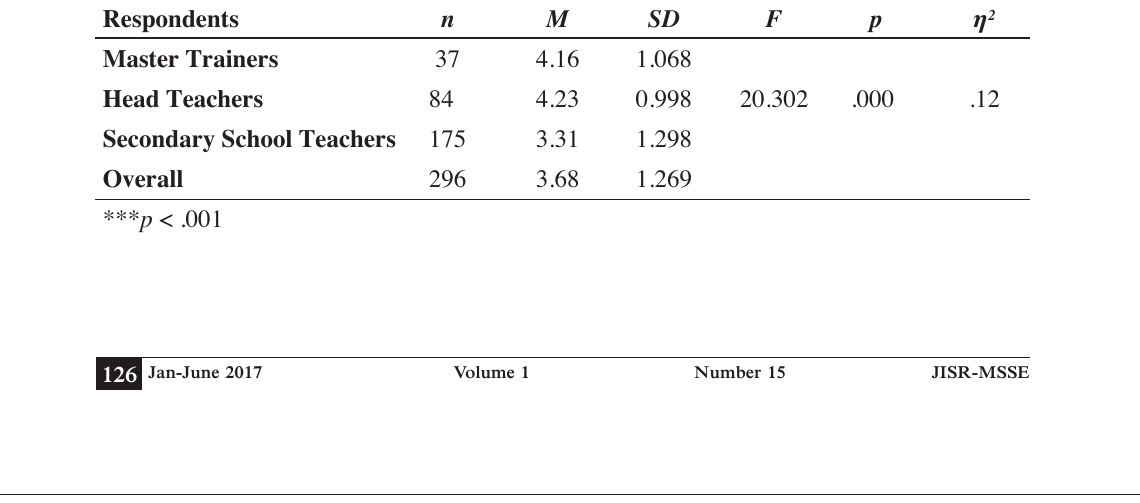
Table.4 Use of information and communication technology in Classroom Saves Lesson’s Time